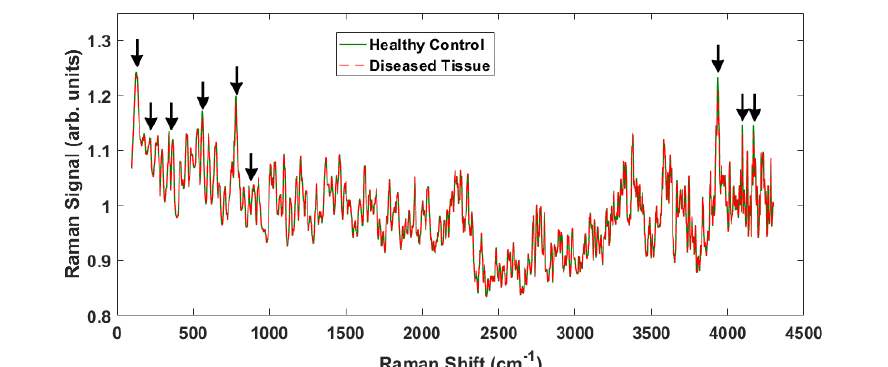
Figure 2. Representative Raman spectra from two different samples, one healthy and one cancerous over the entire ∼ 4000 cm − 1 Raman shift signal. The peaks that show differences between the healthy tissue and the cancerous tissue are indicated by the arrows.